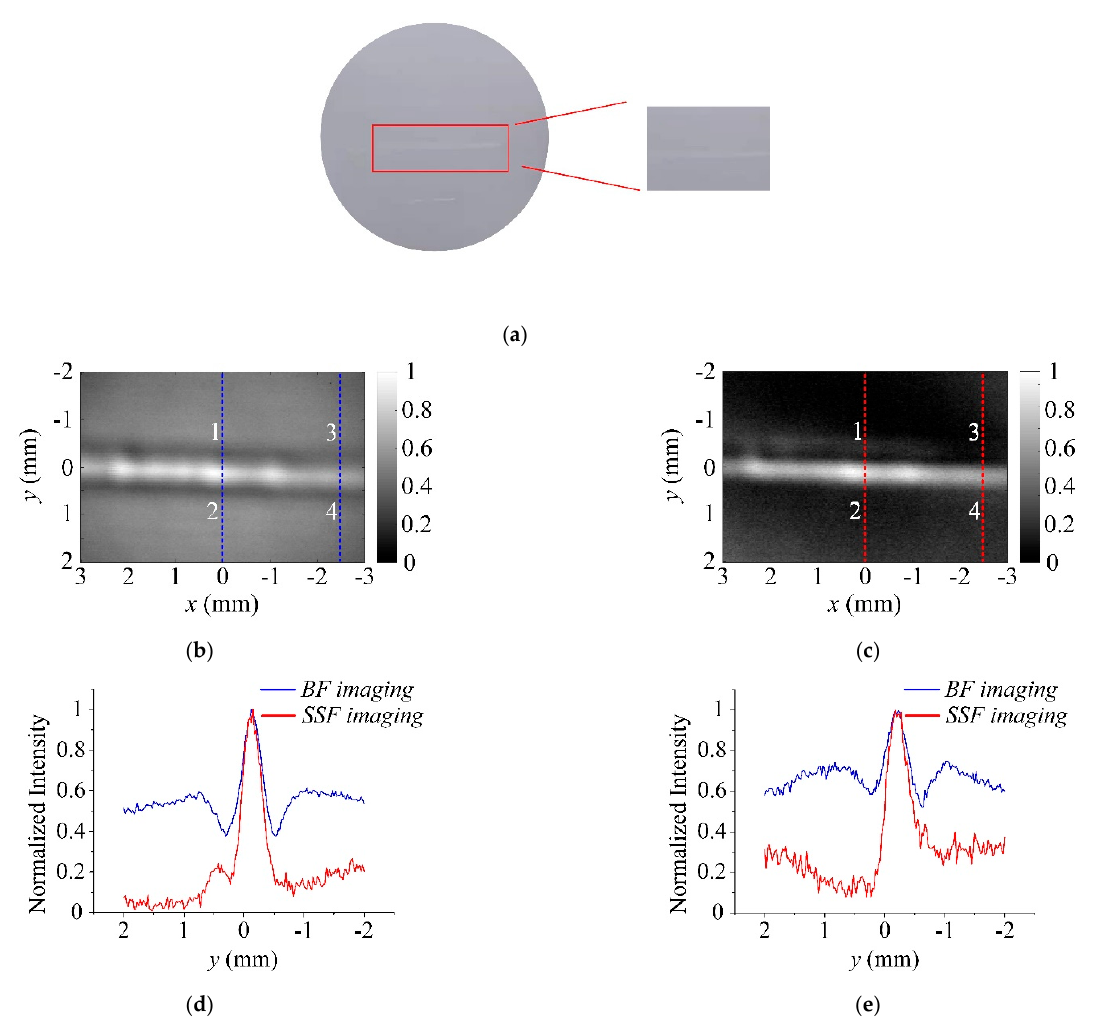
Figure 6. Experimental results for the tested object with low imaging contrast. ( a ) The hardly visible scratch on the HDPE piece. ( b ) The THz BF imaging result. ( c ) The THz SSF imaging result. ( d , e ) The intensity curves corresponding to the blue and red dashed lines in ( b , c ), respectively.